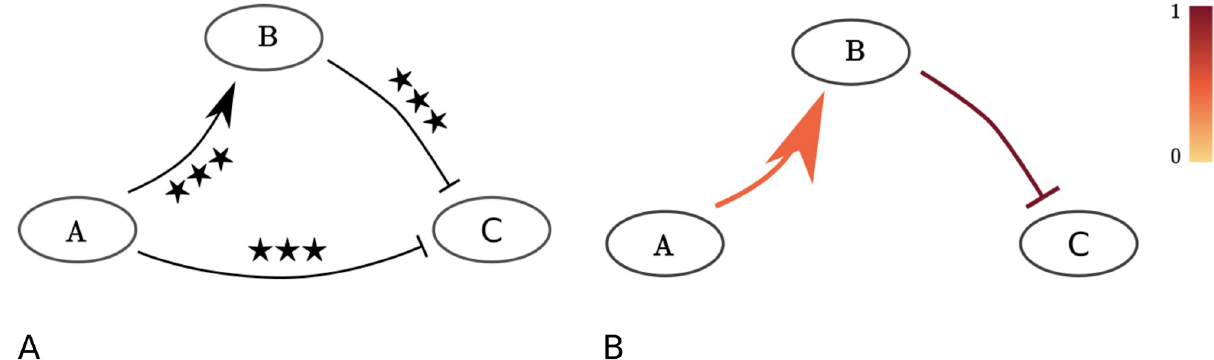
Fig 6. Starting with a set of statistically significant edges (left), we use the AIC to select an optimal model that balances model complexity and fit (right). A: Network extracted using statistical analysis of the synthetic data presented in Fig 1B, corresponding to the toy model shown in Figs 1A and 5IV. Two sample t-test: $$$ p � 0.001, fdr corrected. B: The two-edge network configuration selected by the AIC (see Fig 2), again based on the synthetic dataset presented in Fig 1B. Note the AIC has selected the network configuration that was used to generate the synthetic data set. Edge widths are proportional to the value of the corresponding edge parameter α u , i and β v , i that minimized D for the shown network configuration. Edges are coloured proportional to the increase in D when they are removed from the shown network configuration.